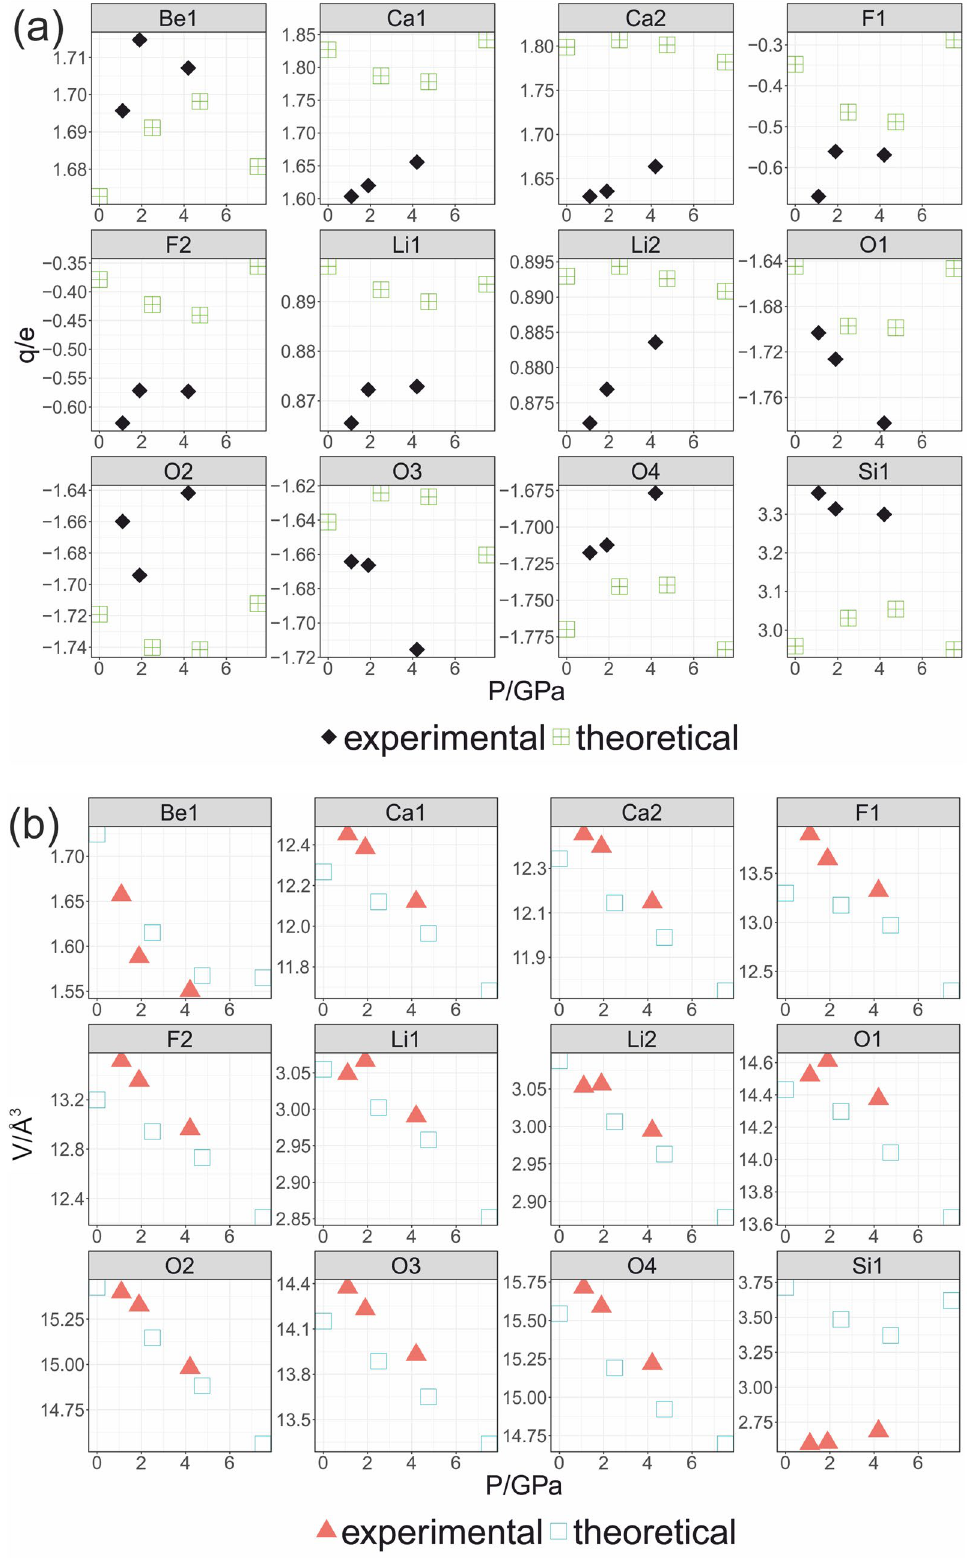
Figure 5. Changes of the ionic charge ( a ) and ionic volume ( b ) for ions in the hsianguhalite crystal structure under